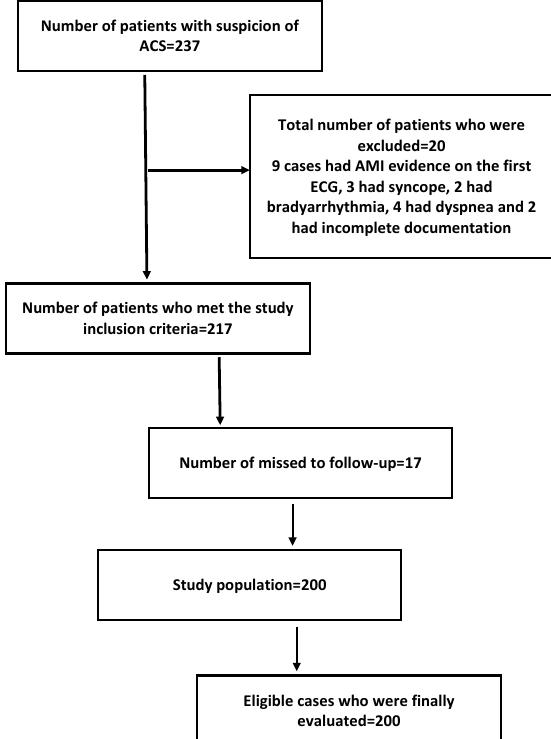
Figure 1. Flow chart of the